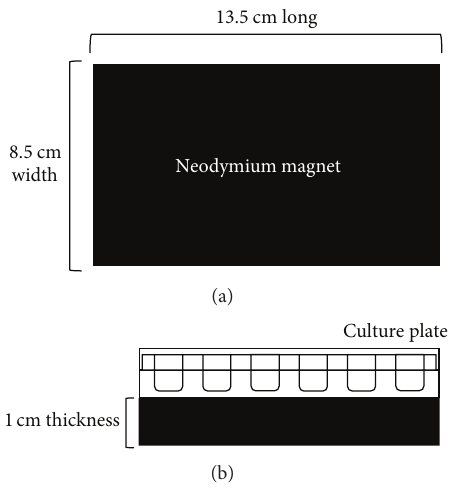
Figure 1: Schematic representation of the static magnetic field equipment setup. (a) Neodymium blocks 13.5 × 8.5 × 1cm were used to provide a 0.4T static magnetic field. (b) The 24-well culture plate was placed directly on the north pole (on the base) of the magnetic